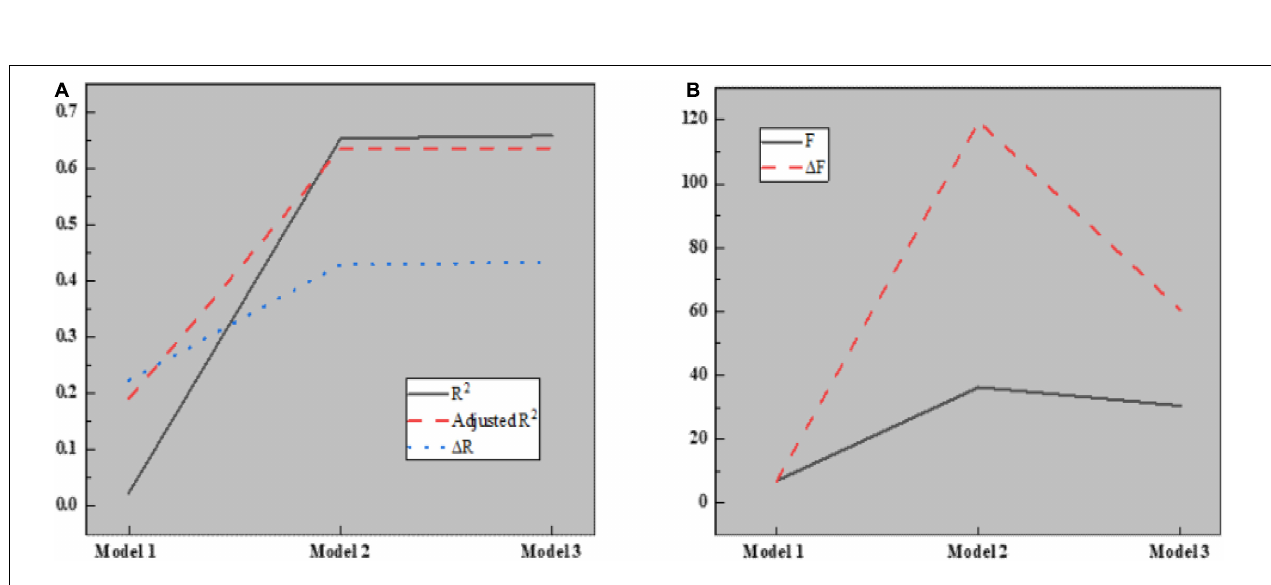
FIGURE 10 | Parameters in regression analysis. (A) Parameters of R 2 ; (B) Parameters of